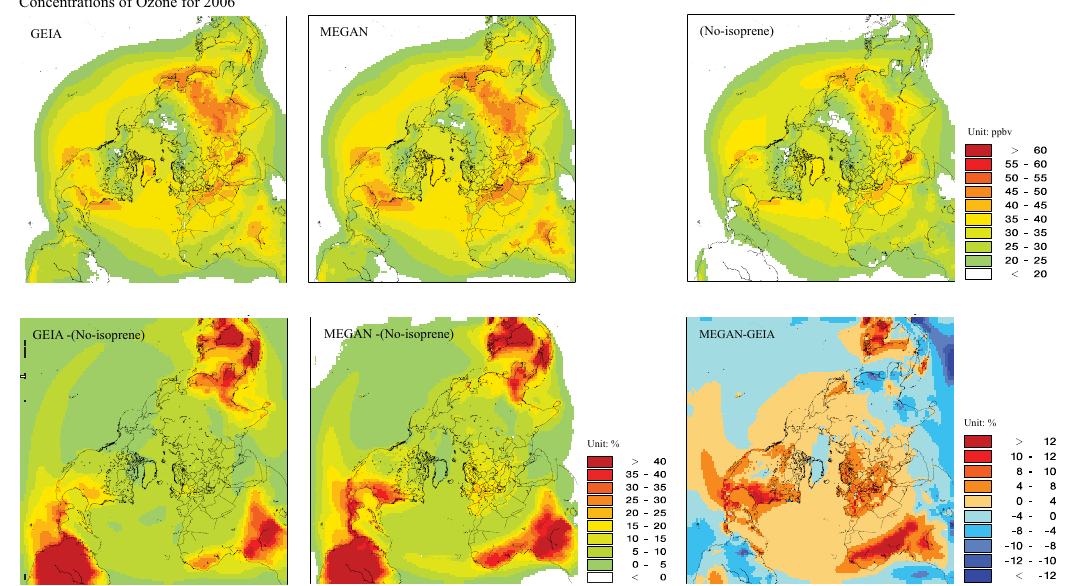
Fig. 11. Ozone concentration (ppbV) simulated by DEHM for the study area using the GEIA (a) and MEGAN (b) isoprene models, and for the biogenic isoprene emissions set to zero (No-Isoprene) (c) in the lowest model layer. Ozone changes due to isoprene estimated by GEIA against No-Isoprene in DEHM (d) and by MEGAN against No-Isoprene in DEHM (e) for 2006. (f) Differences of ozone concentration simulated by DEHM based on the biogenic models of MEGAN and GEIA for